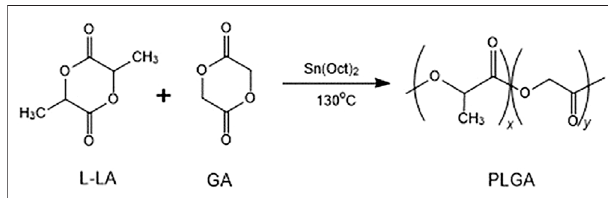
FIGURE 1 | The synthetic route of